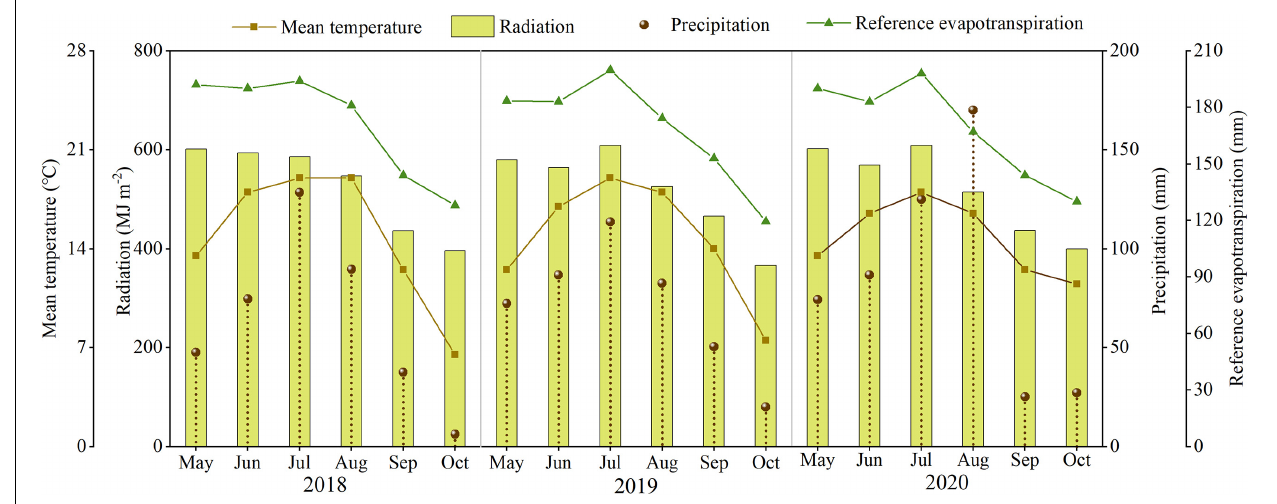
FIGURE 1 | The precipitation, mean temperature, cumulative radiation, and evapotranspiration during the maize growth period in 2018, 2019, and